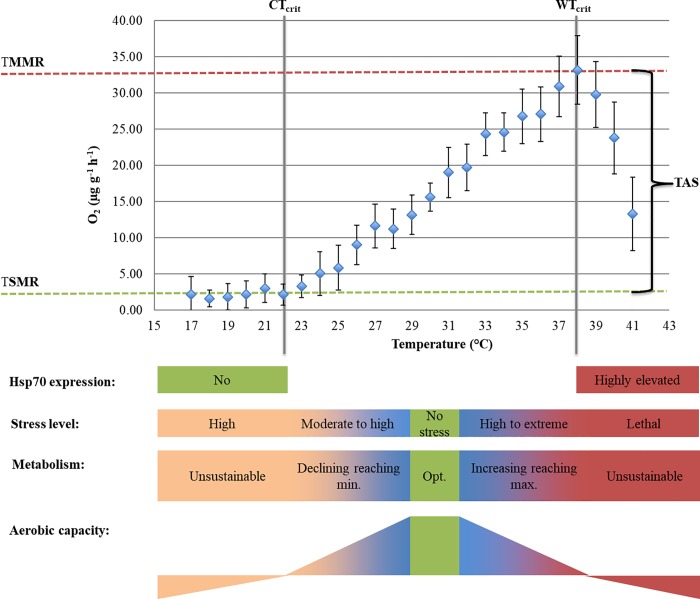
O2 consumption rate of Holothuria scabra at different temperatures, obtained from four warm and cold experimental replications.Points represent means ± s.d. of eight biological replicates (n = 8). Upper red dotted line indicate temperature-induced maximal metabolic rate (TMMR), at the critical warm temperature (WTcrit; 38°C), lower red dotted line marks the start of the temperature-induced standard metabolic rate (TSMR), at critical cold temperature (CTcrit; 22°C). The difference between TMMR and TSMR define the temperature-induced aerobic scope (TAS) for H. scabra (black brace). Beyond CTcrit and WTcrit (22–38°C) progressively negative aerobic performance caused by growing dependency on energy reserves and declining aerobic capacity, respectively, indicate homeostatic disruption. Overexpression of Hsp70 occurs only at the warm temperature maximum (41°C).